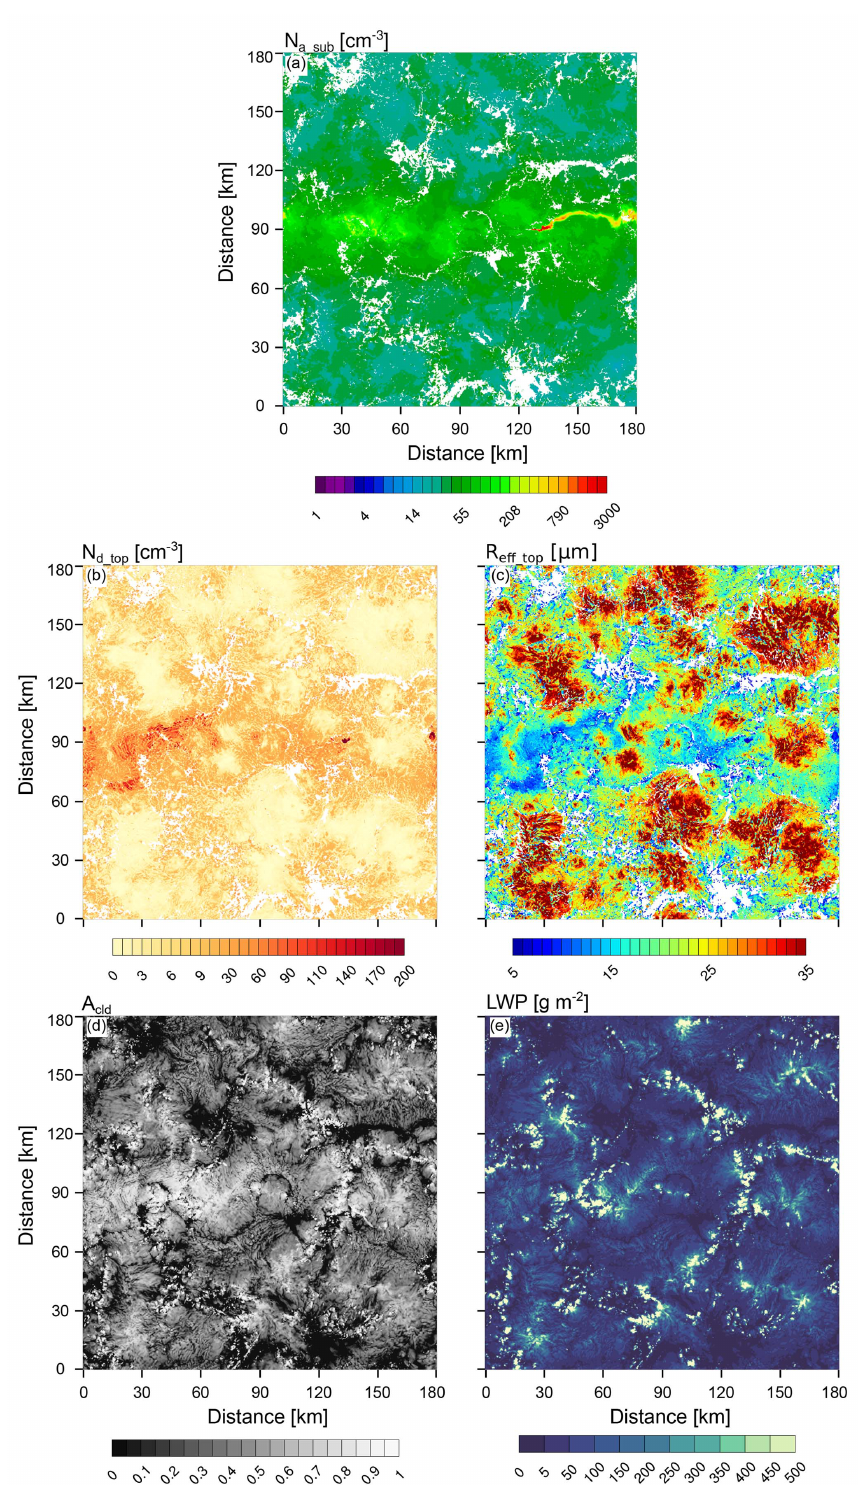
Figure 3. Snapshots of (a) vertically averaged sub-cloud layer aerosol concentration ( N a_sub ), (b) cloud-top cloud droplet number con- centration ( N d_top ) , (c) cloud-top mean effective cloud droplet radius ( R eff_top ), (d) cloud albedo ( A cld ) and (e) liquid water path (LWP). Instantaneous fields are shown at 12:00UTC for the ship simulation. Fields for the ctrl simulation are shown in the Supplement (Fig. S4).